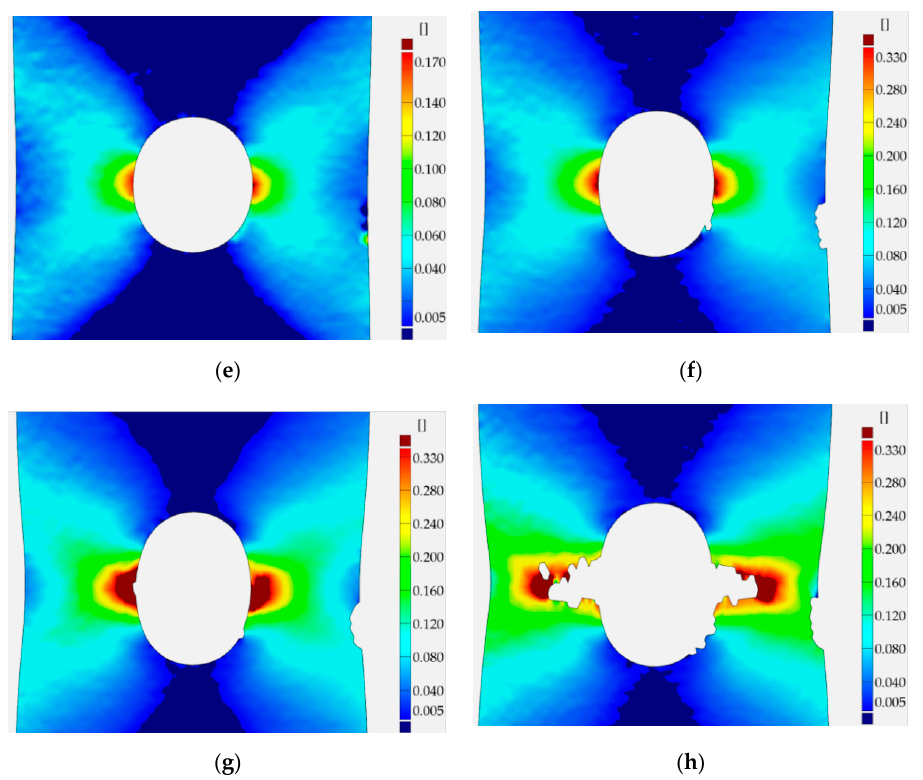
Figure 20. Strains field on investigated surface of plate made of S235JR + N with circular hole calculated with the use of DIC; total vertical displacement u MTS and corresponding vertical ε TOT (in brackets): ( a ) 0.79 (0.44); ( b ) 1.09 (0.61); ( c ) 1.39 (0.74); ( d ) 2,40 (1.34); ( e ) 3.60 (2.00); ( f ) 6.69 (3.72); ( g ) 8.49 (4.72); and ( h ) 10.9 (6.1).